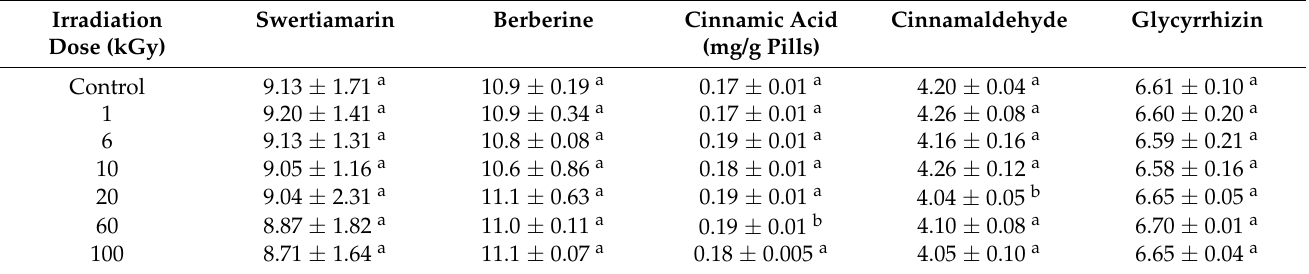
Figure 2. High-performance liquid chromatography (HPLC) chromatograms of the indicator ingredients in the sample pills at non-irradiation (control) and after 100 kGy of EB irradiation. ( a ) Swertiamarin; ( b ) berberine; ( c ) cinnamaldehyde (C. Ald) and cinnamic acid (C. Acid); and ( d ) glycyrrhizin. Table 3. Analysis of the indicator ingredients in the sample pills at varying irradiation